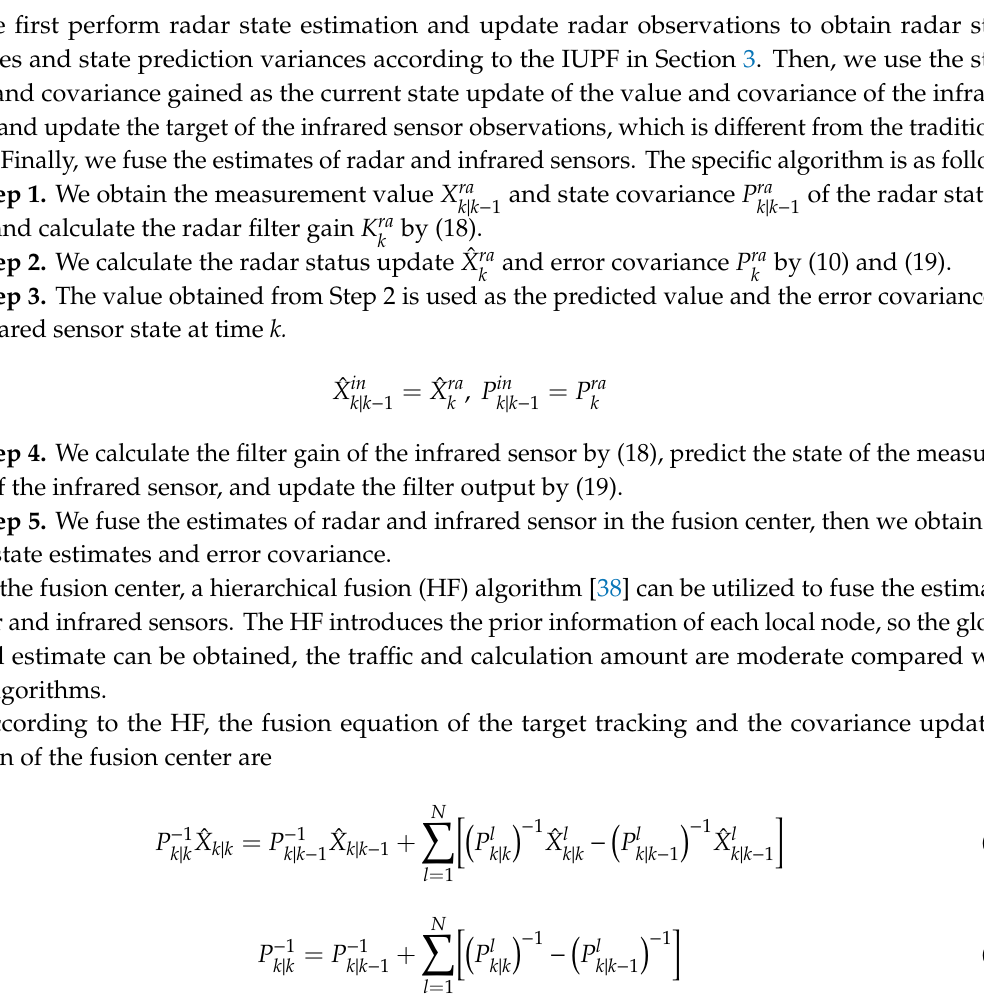
Figure 2. Improved distributed fusion model for single target tracking.